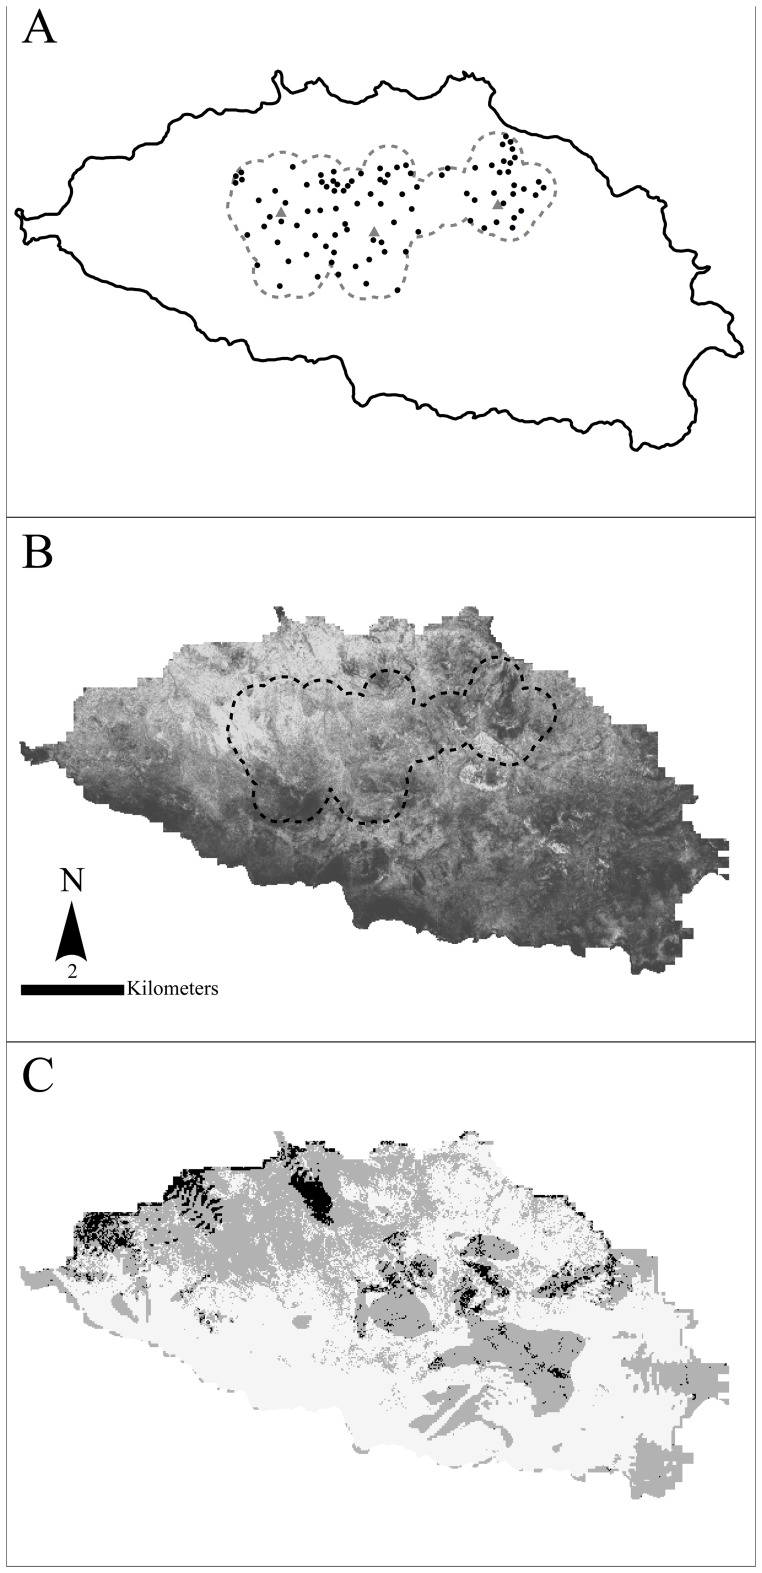
Study areas on Española Island.(A): gray dashed line is “tortoise zone” or maximum extent of tortoises observed on the island since the repatriation program was initiated; black circles are 2010 survey plot locations for tortoises, cactus, and woody plants; gray triangles are tortoise introduction sites (West: Tunas, central: Cacos, East: Gardner). Woody plant cover on Española Island (B; darker shades indicate higher percent woody plant cover), classified using cloud-free Quickbird satellite imagery (December 29, 2006, 0.6 meters resolution) into areas with and without woody vegetation using a supervised classification calibrated with plot woody plant density estimates (IDRISI Andes 5.0) (percent cover is the percent vegetated cells per 24 m×24 m area). Potentially highly suitable cactus restoration areas (C) with low slopes (<2.06 degrees, bottom quartile of available slopes) and low woody plant cover (<52% cover woody plants, bottom quartile of available woody plant cover); black areas have both low slopes and low woody cover, gray areas have either low slope or low woody cover.